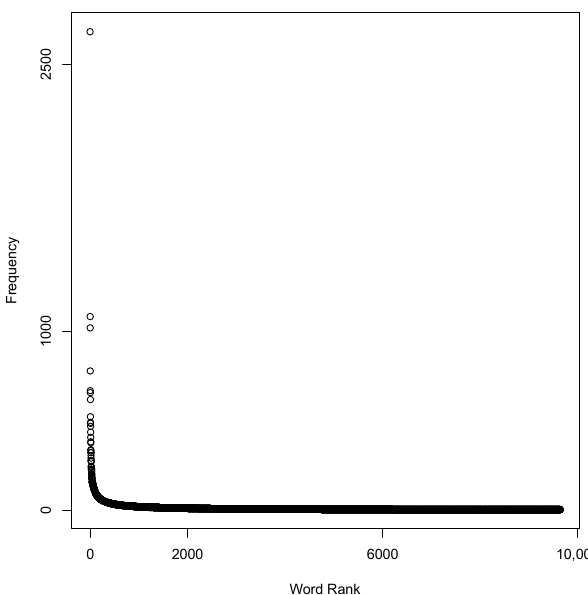
Figure 2. Frequency of words and Zipf’s law.